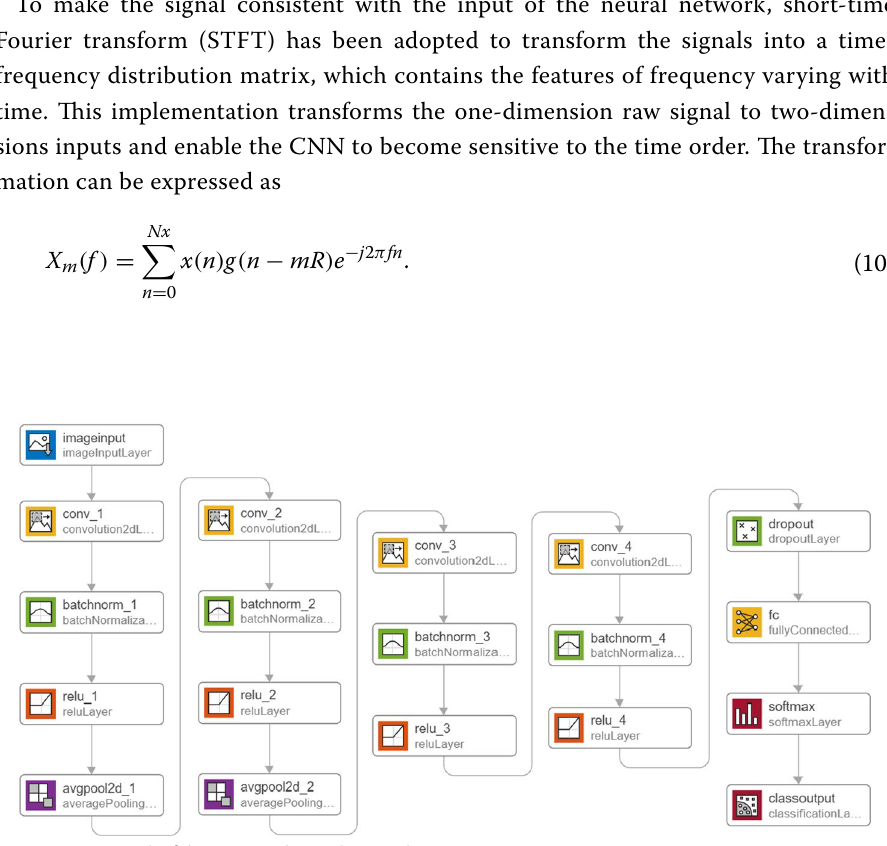
Fig. 9 Framework of the proposed neural